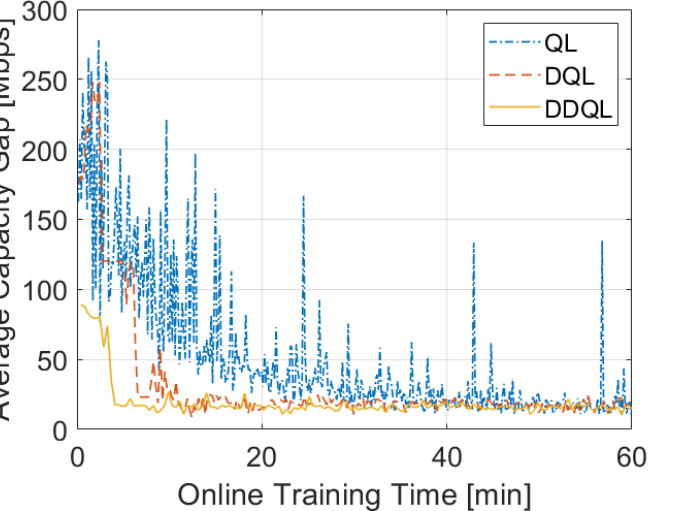
Figure 10. Average capacity gap for online-trained algorithms depending on training time. Note: The times obtained depend on the computer features used. If computer performance is increased, the time required will be considerably